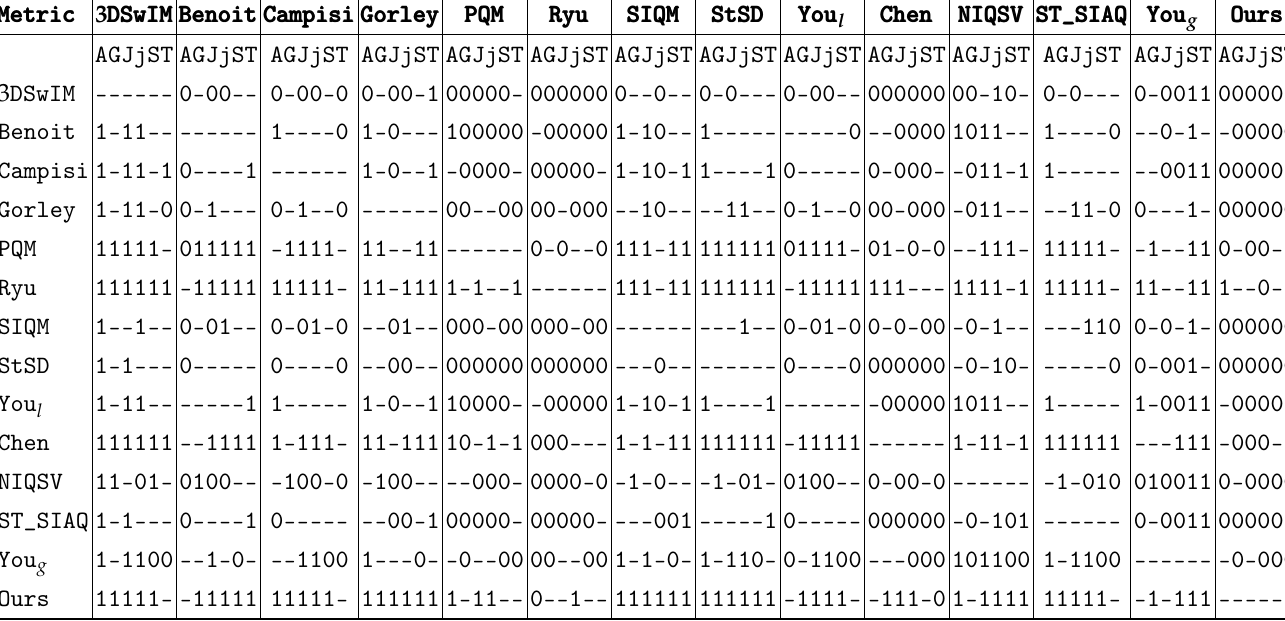
Table 6. Statistical significance tests of proposed and other 3D-IQA metrics on MCL-3D dataset. Value ‘1’ means the metric in the row is significantly superior to that of the column. Value ‘0’ means the metric in the row is significantly inferior to that of the column and ‘-’ means both the metrics are significantly equivalent. The symbols A, G, J, j, S, and T represent the distortions for AWN, Gauss, JP2K, JPEG, Sample, and Transloss,